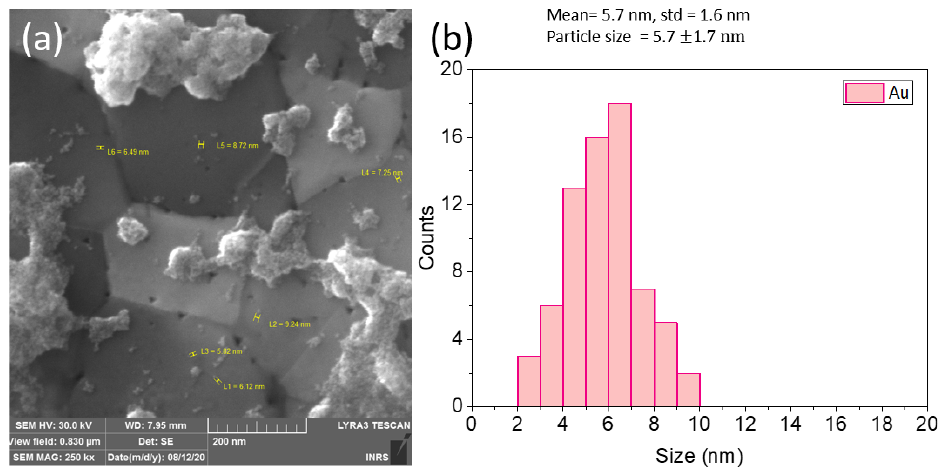
Figure 1. ( a ) SEM image and ( b ) particle size distribution of the Au nanoparticles grown by PLAL.